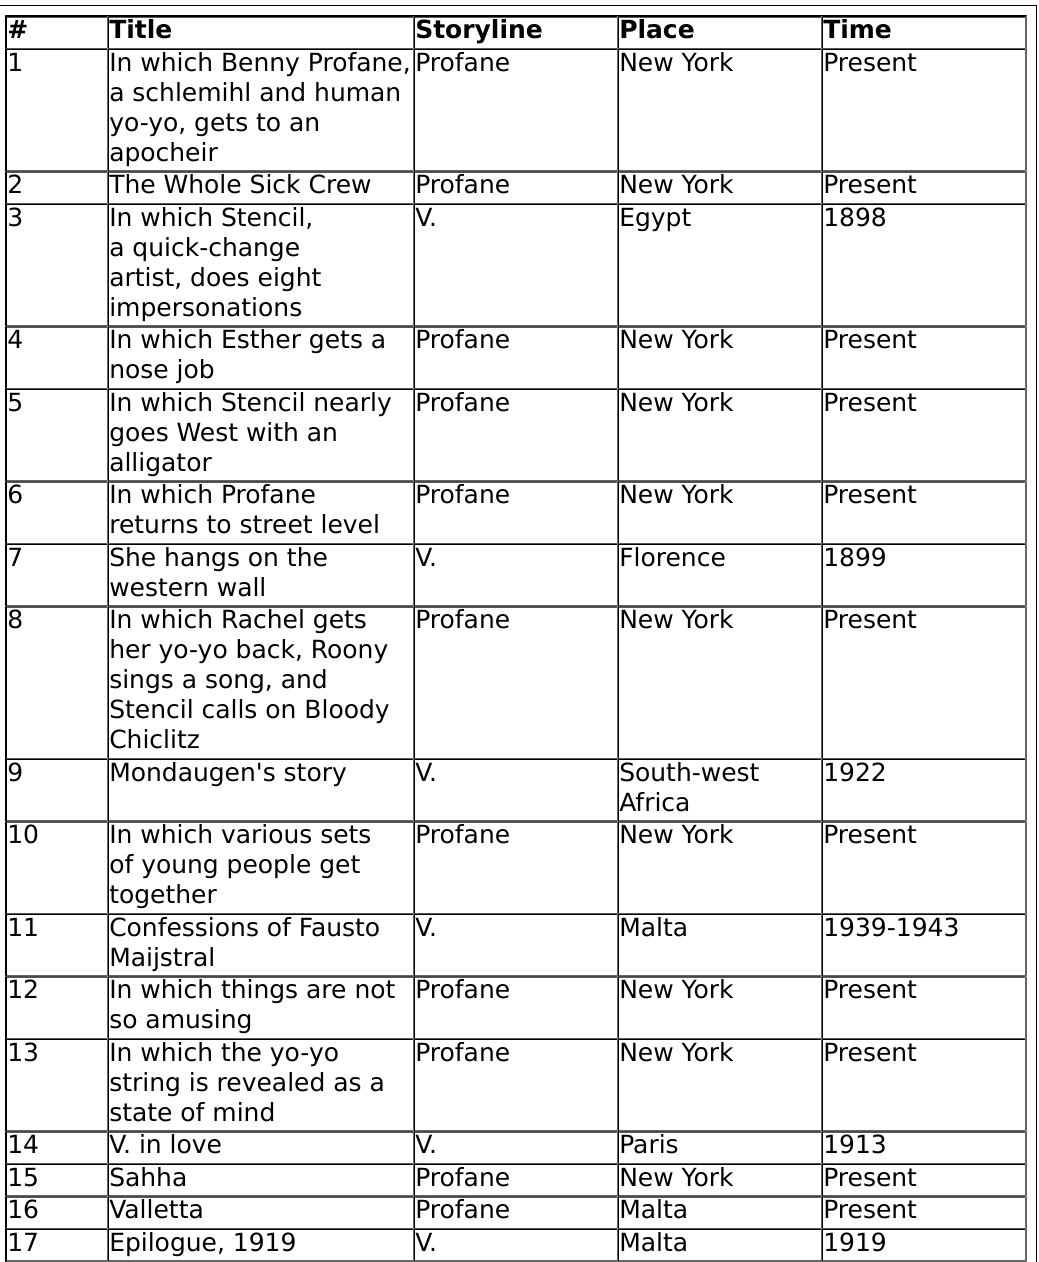
Table 2: Overview of the book chapters, including the mapping of chapters-